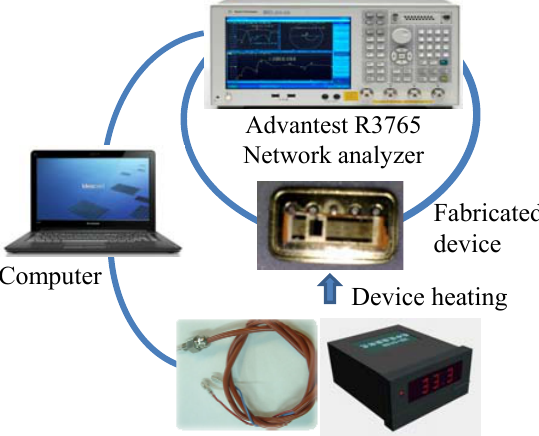
Figure 6. The temperature stability measurement setup of the fabricated devices.